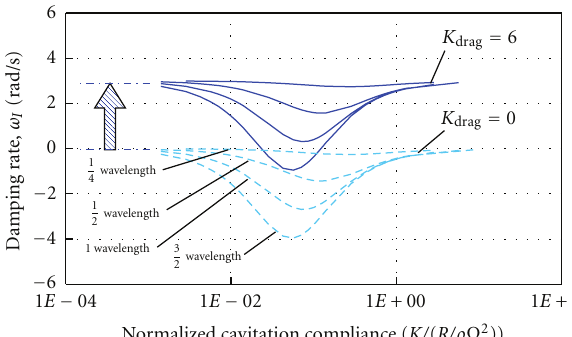
Figure 7: Analytical results of imaginary part, ω I , showing e ff ect of Mρ Ω = 0 . K drag (